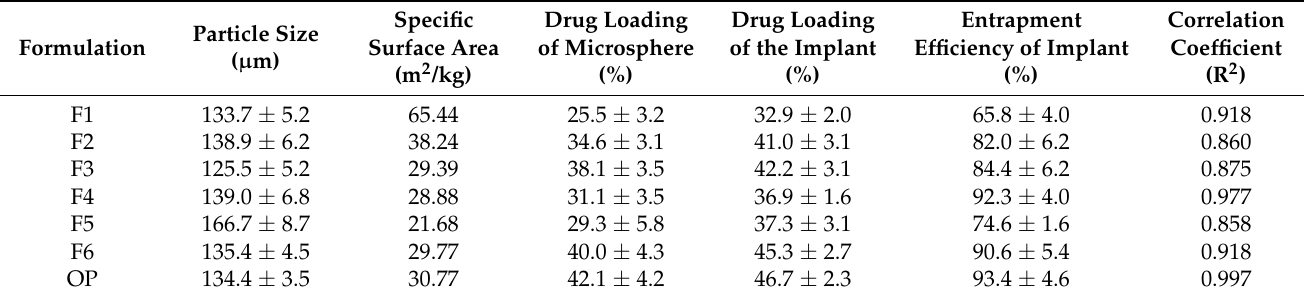
Table 4. Physical and chemical properties of different microsphere formulations.